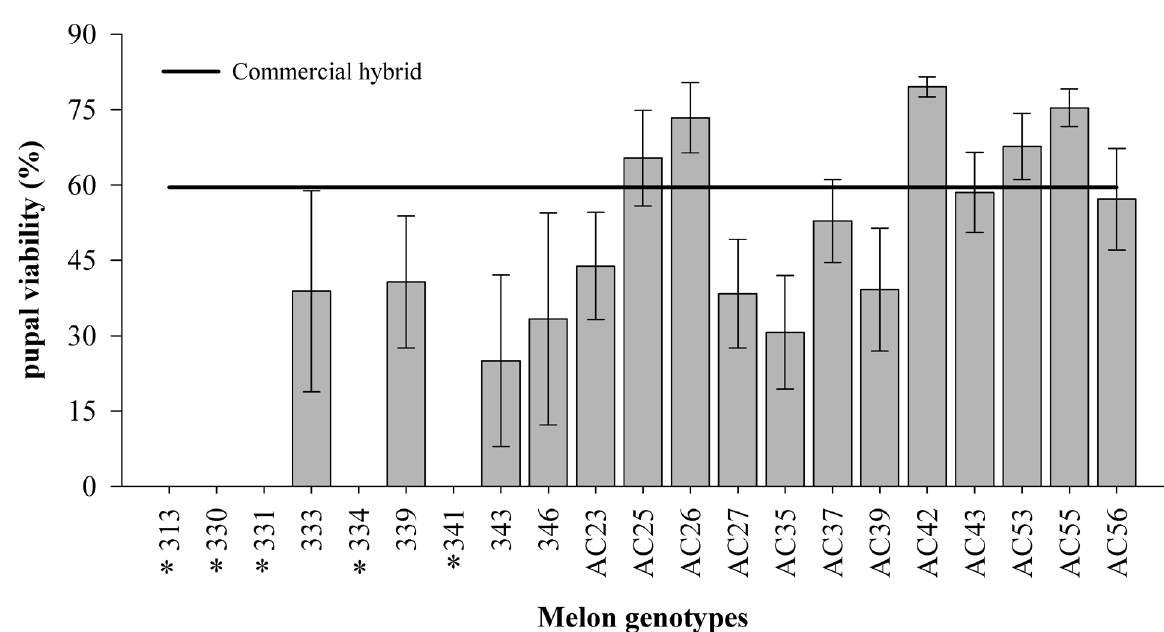
Figure 4. L. sativae pupal viability in melon genotypes. Genotypes followed by asterisks indicates a significant difference in relation to the commercial hybrid by Dunnett’s test (α = 0.05). Line in bold (mean pupal viability of the susceptible standard genotype), Bars (mean pupal viability of genotypes with standard